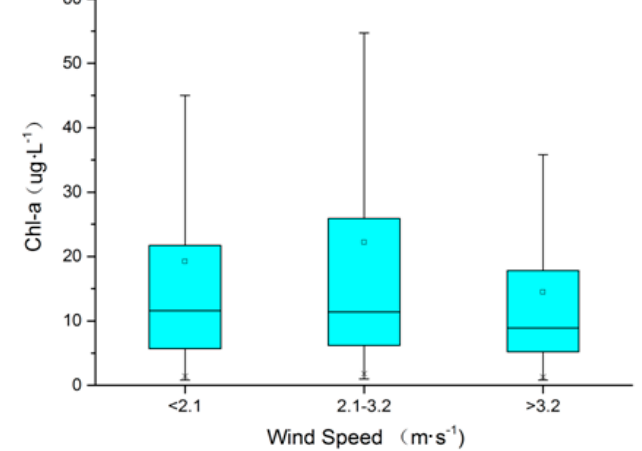
Figure 9. The whisker’s boxplot of total phosphorus (TP) concentration for the three wind speed groups.